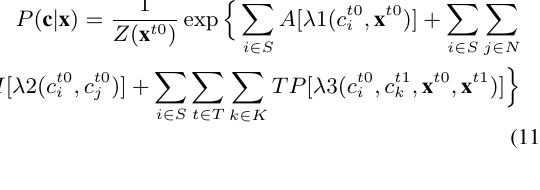
Figure 4. Approach 1, RF, classification used as